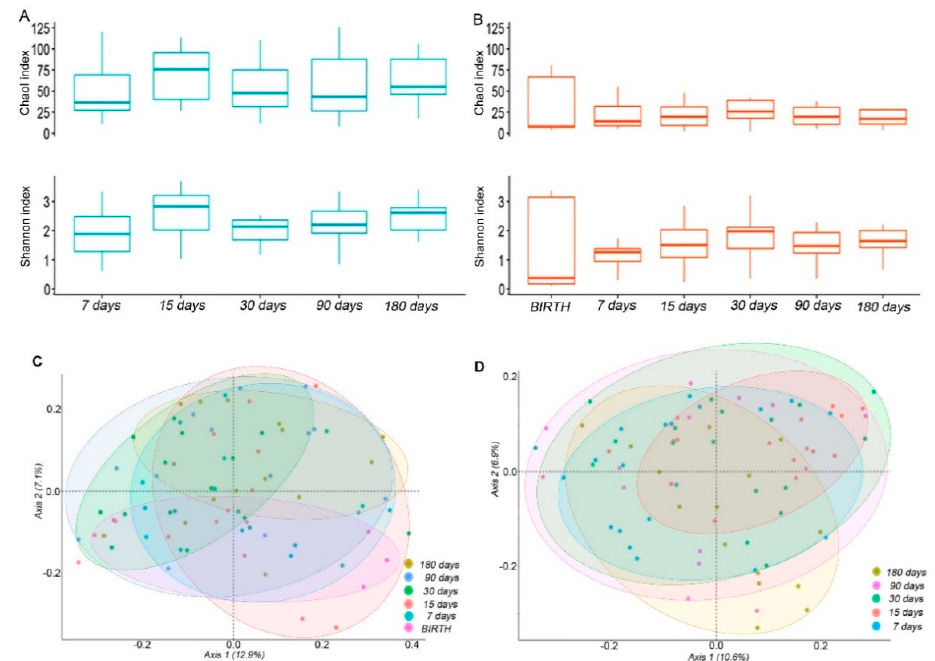
Figure 1. Ecology of the salivary and intestinal microbiota. ( A , B ) box plots of the Chao1 and Shannon indexes of the saliva ( A ) and stool ( B ) samples. Boxes represent the minimum and maximum values, median, 25th, and 75th percentiles of indexes at the indicated time points. ( C , D ) Principal coordinates analysis (PCoA) plots of the unweighted UniFrac matrix of all the time-points for the saliva ( C ) and stool ( D ) samples. The shape of the symbols refers to the microbiota matrix, while the colour indicates the time point. The plots show the percentage of variance that is explained in the first two axes.